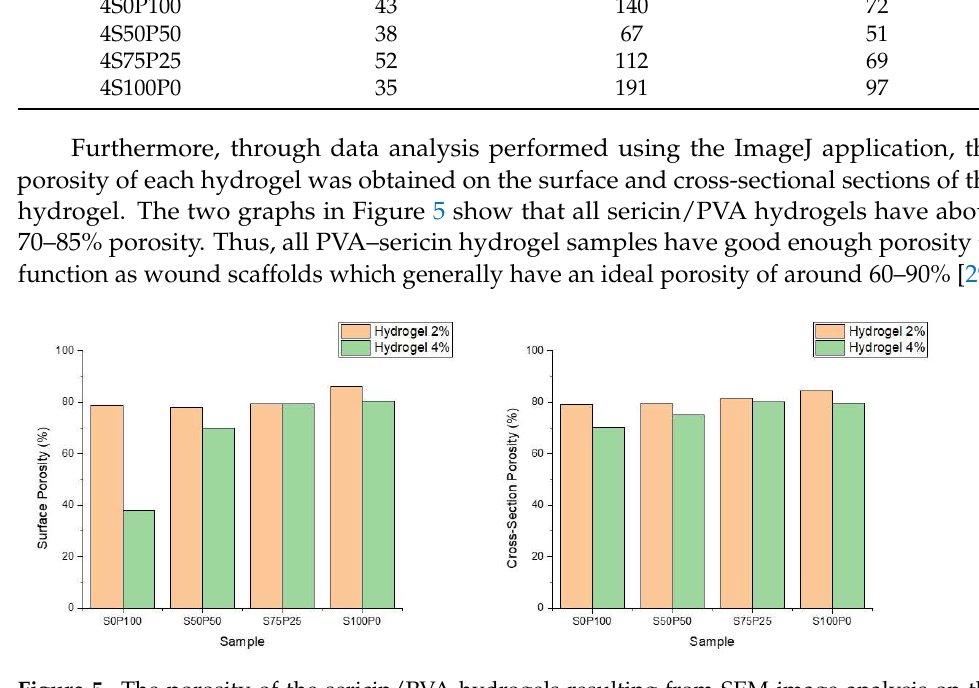
Table 4. The average pore diameter in the cross-section of the hydrogel samples. Sample